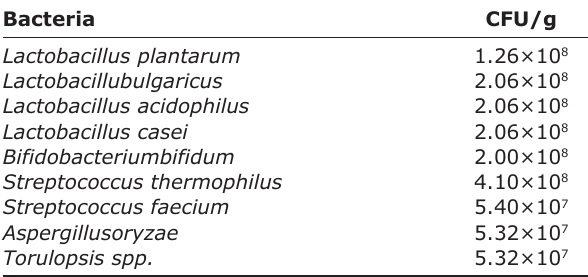
Supplementary Table-1: Composition of the basal diets: starter (d 0–20), grower (d 21–34). Ingredient